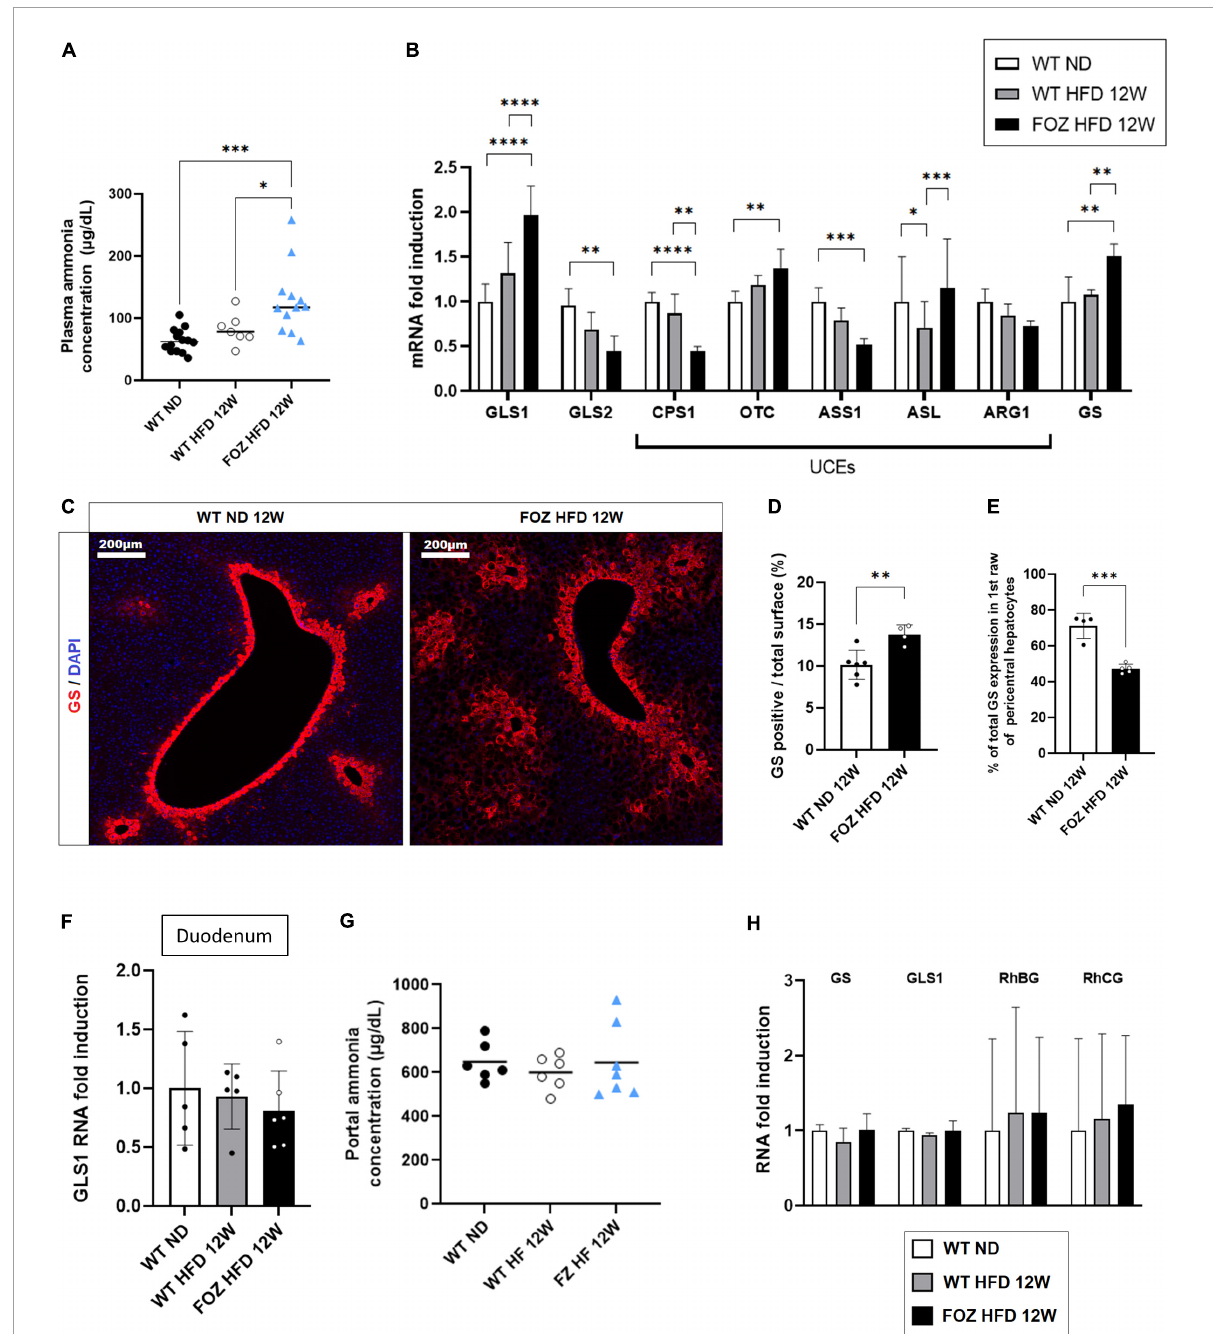
FIGURE2 Hepatic ammonia detoxification is altered in NASH but not in simple liver steatosis. (A) Plasma ammonia concentrations measured in systemic blood from wild-type normal diet (WT ND), WT high-fat fed (WT HFD), and HFD-fed fat aussie (FOZ HFD) mice after 12 weeks of diet ( n = 7–14); (B) mRNA levels of glutaminase (GLS) 1 and 2, of urea cycle enzymes (UCEs): carbamoyl phosphate synthetase (CPS1), ornithine transcarbamylase (OTC), Argininosuccinate synthetase (ASS1), argininosuccinate lyase (ASL), arginase (ARG1), and of glutamine synthetase (GS) in liver tissue from WT ND, WT HFD, and FOZ HFD after 12 weeks of diet ( n = 4–9); (C) GS protein expression levels assessed by immunofluorescence in liver from WT ND and FOZ HFD after 12 weeks of diet; (D) Quantification of GS-positive tissue (in percentage) in liver sections from WT ND and FOZ HFD after 12 weeks of diet and (E) percentage of GS staining localized in the first raw of pericentral hepatocytes ( n = 4–6); (F) mRNA levels of GLS1 in duodenum from WT ND, WT HFD, and FOZ HFD after 12 weeks of diet ( n = 5–6); (G) Plasma ammonia concentrations measured in portal blood from WT ND, WT HF, and FOZ HFD after 12 weeks of diet ( n = 6–7); (H) mRNA levels of GS, GLS1, and Rh Family B and C Glycoproteins (RhBG, RhCG) in muscle tissue (gastrocnemius) from WT ND, WT HFD, and FOZ HFD after 12 weeks of diet ( n = 5–7). All data are represented as mean ± SD, ∗ p < 0.05, ∗∗ p < 0.01, ∗∗∗ p < 0.001, ∗∗∗∗ p < 0.0001. Statistical tests used: (D,E) Unpaired two-tailed t -test. (A,F,G) one-way ANOVA and (B,H) two-way ANOVA followed by post hoc Bonferroni